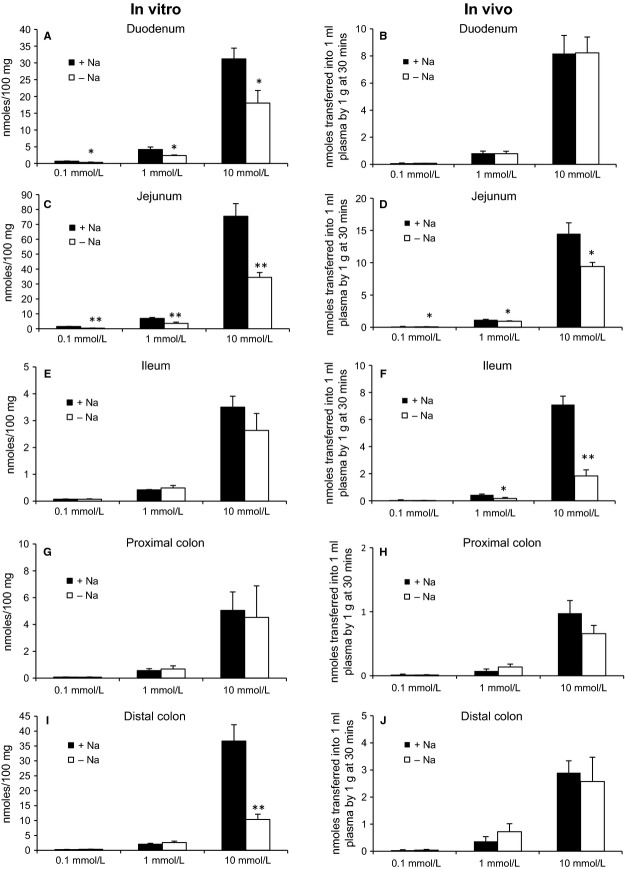
Phosphate transport measured in vitro and in vivo using duodenal, jejunal and ileal regions of small intestine, and proximal and distal colon. Total phosphate transport in the presence of Na+ (solid bars) and Na+‐independent transport in the presence of ChCl (open bars) was determined using buffers containing phosphate concentrations of 0.1, 1, and 10 mmol/L. Na+‐dependent uptake is representative of total transport minus that observed following replacement of NaCl with ChCl. Data are means ± SEM. *P < 0.05, **P < 0.01 compared with absorption in the same region in the presence of Na+ using unpaired t‐test; n =6–9.